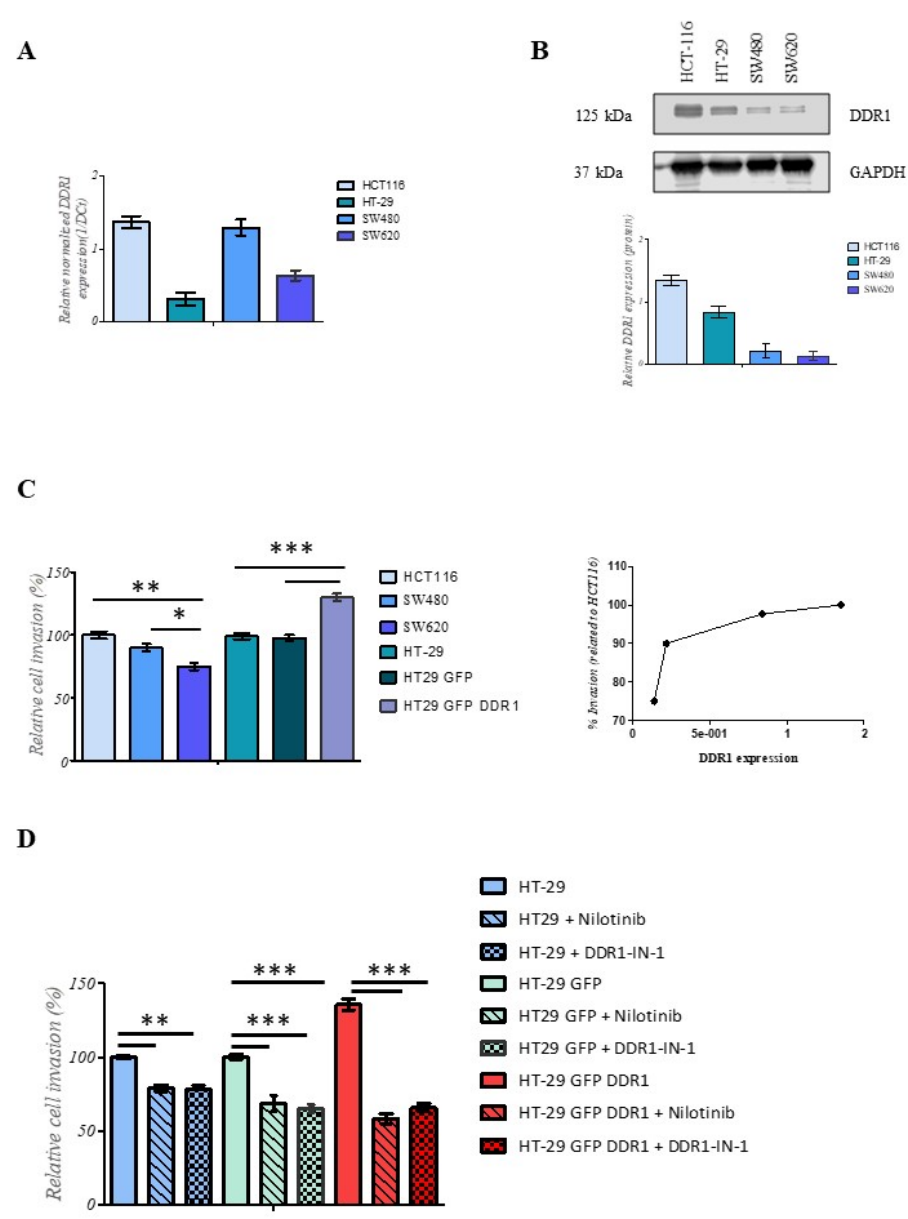
Figure 6. Human CRC cell invasion is modulated by DDR1 expression. ( A ) The relative mRNA expression of DDR1 was assessed using RT-qPCR. Values in HCT-116, HT-29, SW480, and SW620 were normalized with both RPL32 and RS18 mRNA expression. ( B ) The expression of DDR1 and GAPDH was assessed by western blotting using anti-DDR1 and anti-GAPDH antibodies in HCT-116, HT-29, SW480, and SW620 cells. Quantitative analysis of DDR1 protein was obtained by densitometry: the amount of DDR1 was normalized to GAPDH expression level (bottom panel). ( C ) HCT-116, HT-29, SW480, and SW620 were seeded into the collagen type I coated chambers for 24 h. Cells were then fixed with methanol and stained with DAPI. Results are expressed as mean ± SD of three independent experiments. Statistical significance was analyzed by a one-way ANOVA test using Dunnett’s multiple comparisons. * p = 0.05, ** p = 0.01, *** p = 0.001 as compared to HCT-116 cells or HT-29 cells. Correlation between DDR1 expression and cell invasion (right panel). ( D ) HT-29, HT-29 DDR1-GFP , and HT-29 GFP cells were seeded into the collagen type I coated chambers for 24 h in absence or presence of nilotinib (100 nM) or DDR1-IN-1 (10 μ M). Cells were then fixed with methanol and stained with crystal violet. Results are expressed as mean ± SD of three independent experiments. Statistical significance was analyzed by a one-way ANOVA test using Dunnett’s multiple comparisons. ** p = 0.01, *** p = 0.001 as compared to HT-29, HT-29 DDR1-GFP , or HT-29 GFP cells.